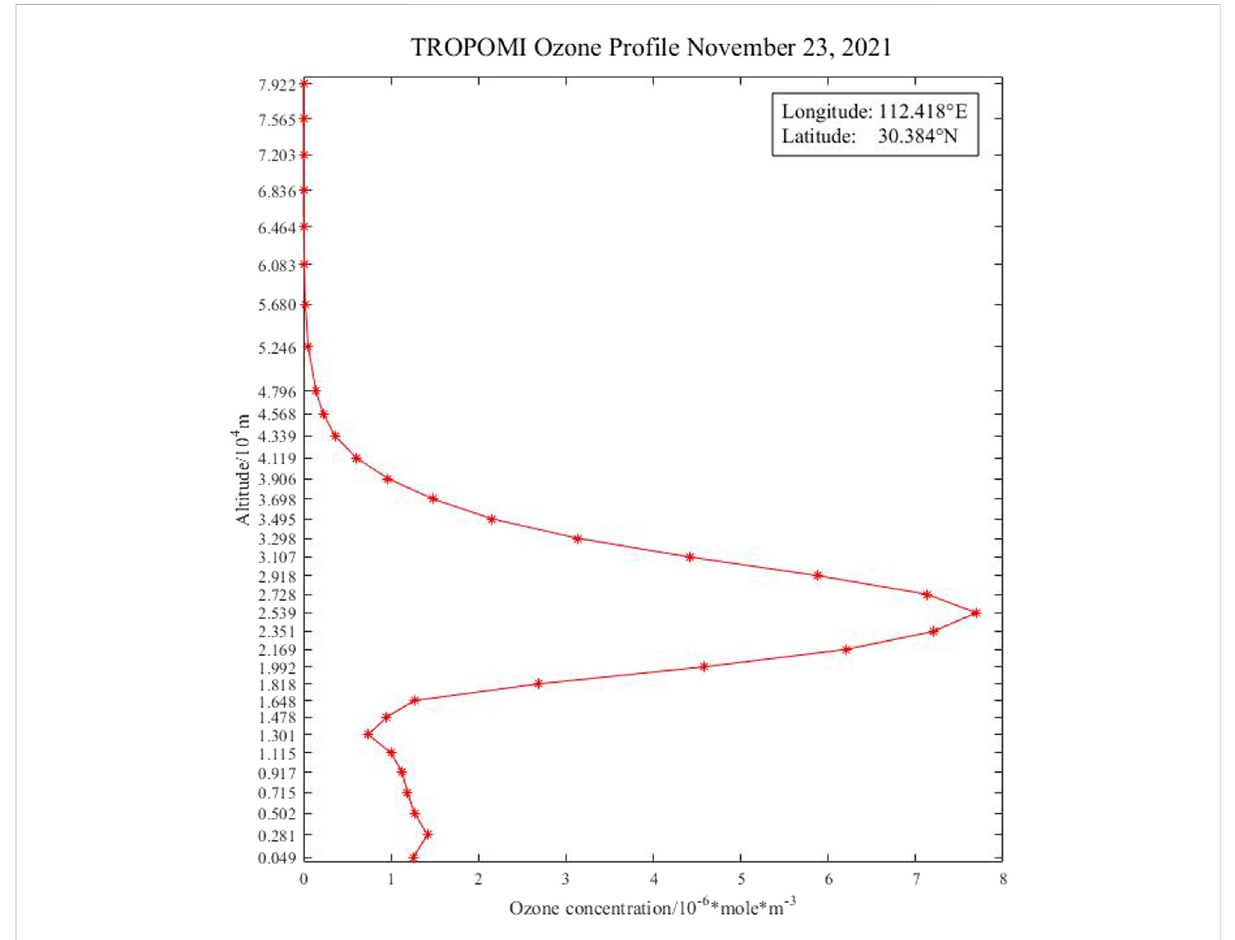
FIGURE 1 Tropomi ozone pro fi le (November 23,